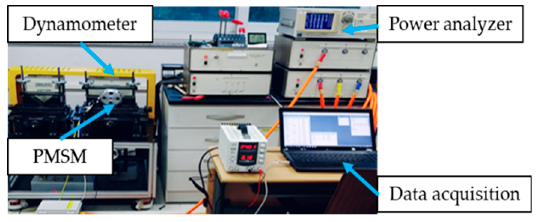
Figure 15. Experimental setup for motor dynamo testing.